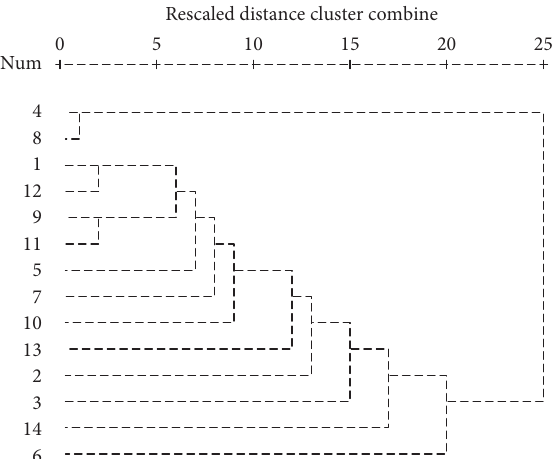
Figure 3: Dendrogram of the 14 compounds using average linkage (within group), z scores